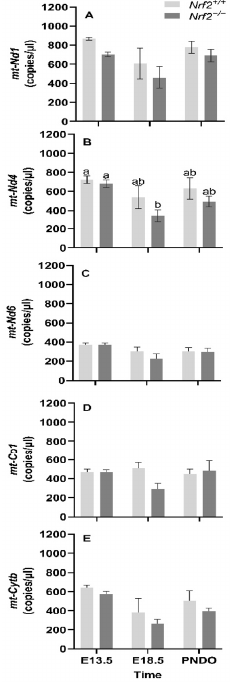
Figure 1. Effect of Nrf2 deletion on lung mitochondria-encoded mitochondrial gene expression during embryonic development and at birth. Mitochondria-encoded mitochondrial genes, NADH dehydrogenase 1 ( mt-Nd1 ) ( A ), mt-Nd4 ( B ), mt-Nd6 ( C ), cytochrome c oxidase subunit 1 ( mt-Co1 ) ( D ), and cytochrome B ( mt-Cytb ) ( E ), were determined in lungs at embryonic (E) days 13.5 and 18.5 or postnatal day 0 (PND0, day of birth) from wild-type ( Nrf2 +/+ ) and Nrf2 -deficient ( Nrf2 − / − ) mice by digital droplet PCR. Nrf2 +/+ Mean ± S.E.M. presented ( n = 5–6/group). A two-way ANOVA was employed with age (E13.5, E18.5, PND0) and genotype ( Nrf2 +/+ , Nrf2 − / − ) as the factors. Letters were used when there were significant main effects ( p < 0.05). Bars not connected by the same letter are significantly different ( p <